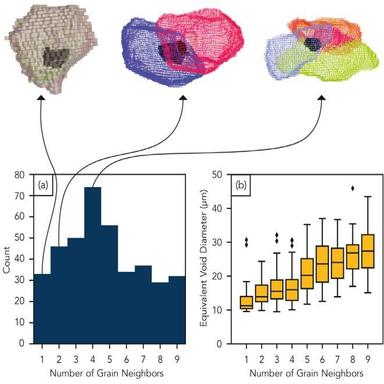
(a) Histogram of number of grain neighbors per each void. (b) Equivalent void diameters for each type of void, shown as a box plot with the line showing the median, and with diamonds indicating outliers.